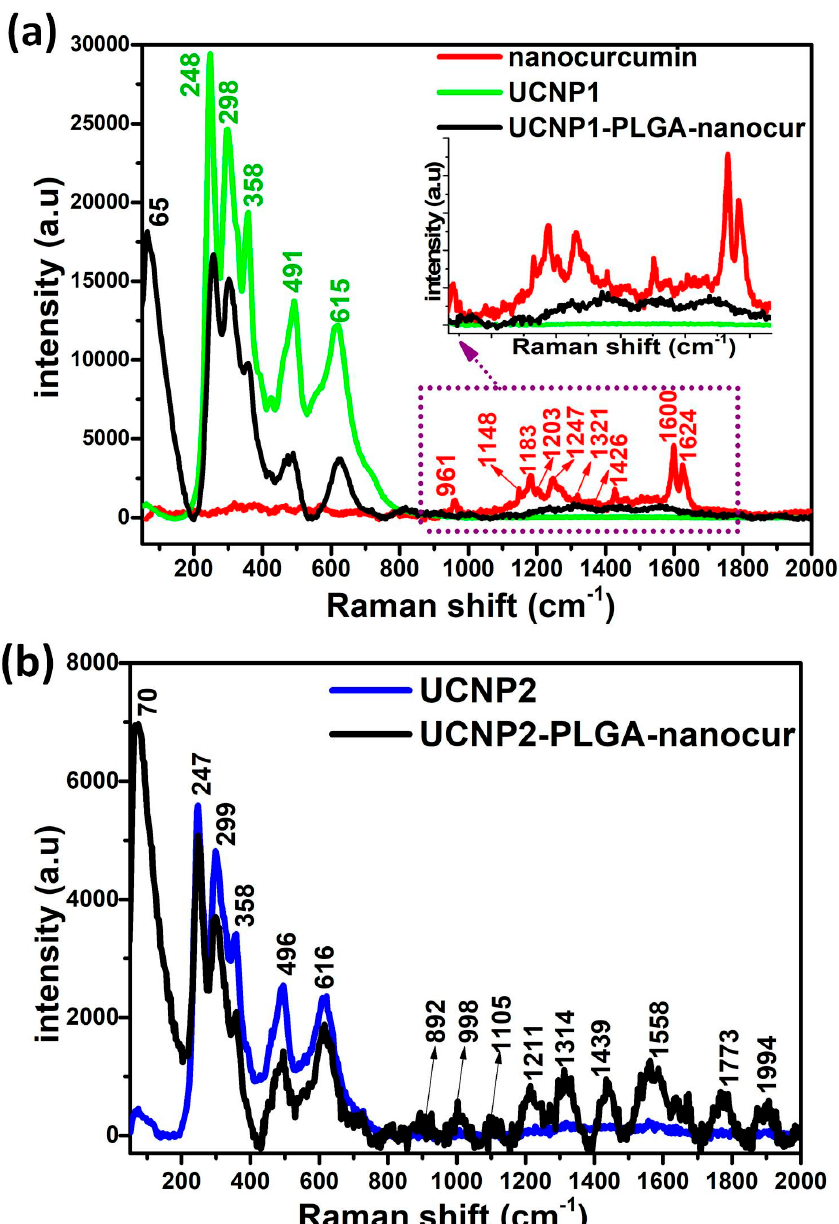
Figure 5. ( a ) Raman spectra of Nanocurcumin, NaYF 4 :Yb,Er (UCNP1), UCNP1-PLGA-nanocur ( b ) NaYF 4 :Yb,Tm (UCNP2), UCNP2-PLGA-nanocur composites.